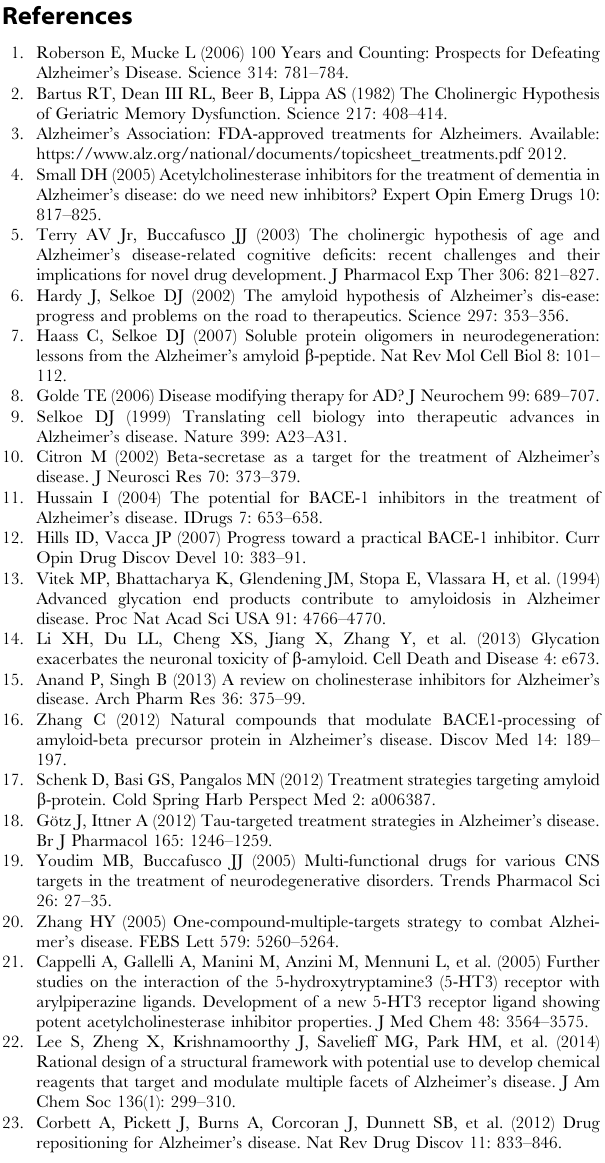
dependent decrease in thioflavin T fluorescence was observed. Table S1 Acetylcholinesterase-protriptyline interaction energy calculations. Interaction energy of ligand with active site residues averaged over last 20 ns of all simulated trajectories. Interaction strengths are in kcal mol-1 unit. Standard deviations are provided within braces. Table S2 Inter-residue distance between active site of AChE residues averaged over last 20 ns of free (vertical) and ligand bound (horizontal) simulated trajectories. Distances are in A˚ unit. Standard deviations are provided within braces. Method S1 Inhibition of Insulin and BSA